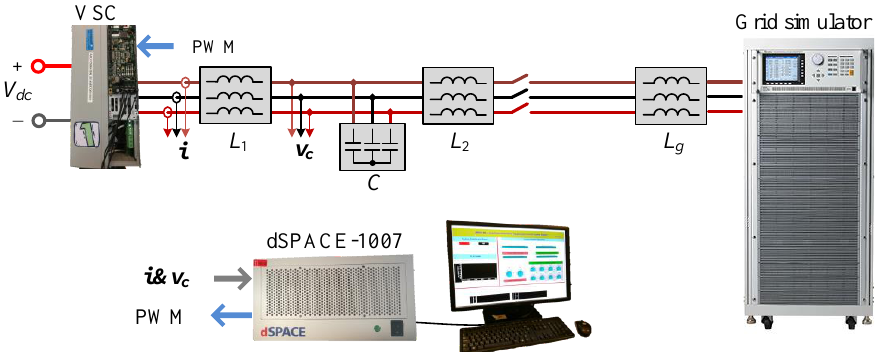
Figure 14. Single line diagram of bonaire island power Fig. 14. Single line diagram of bonaire island power system